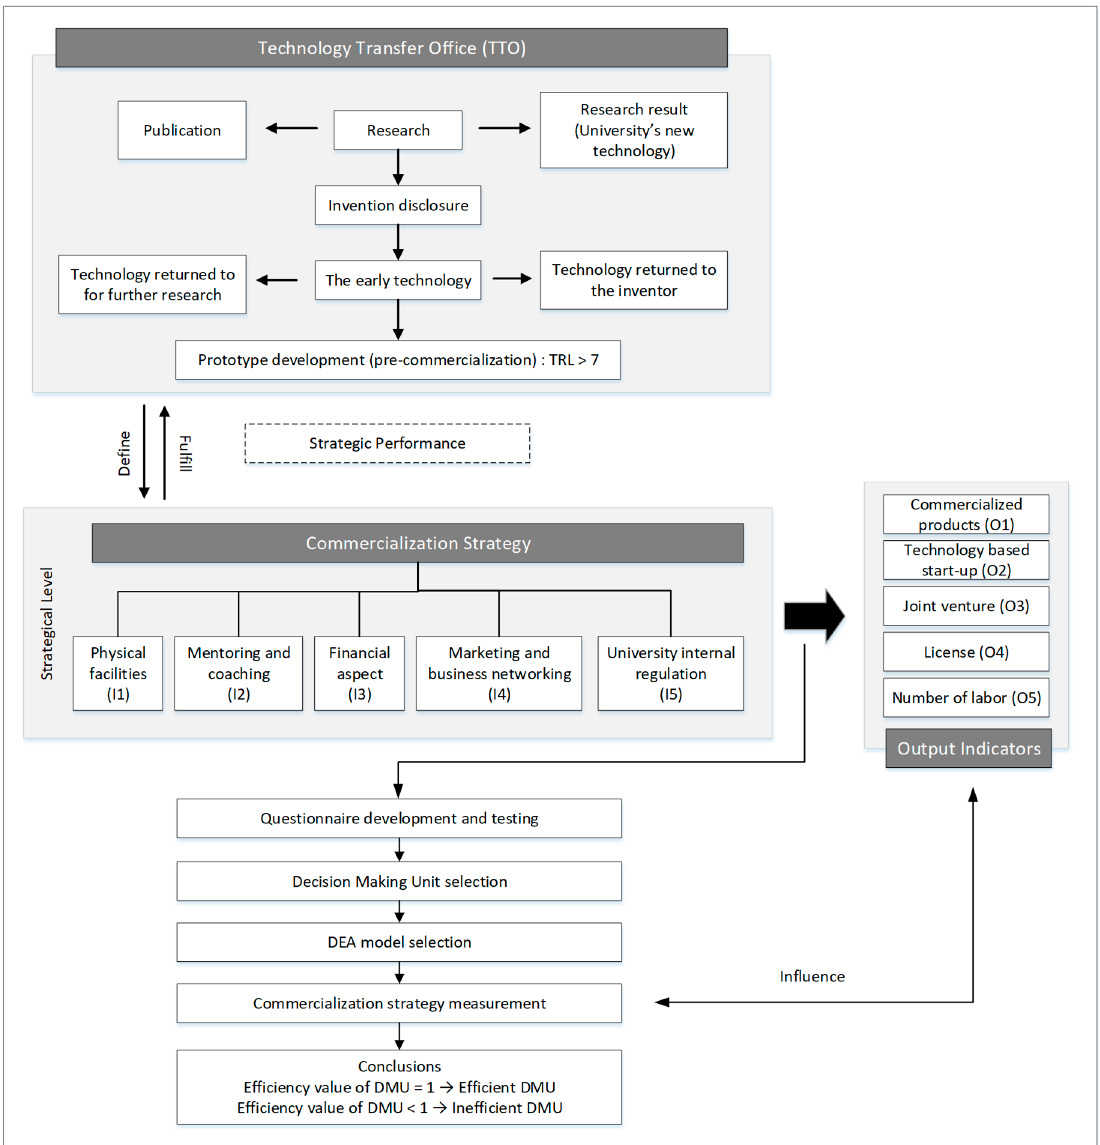
Figure 4. Performance measurement framework of commercialization strategy.